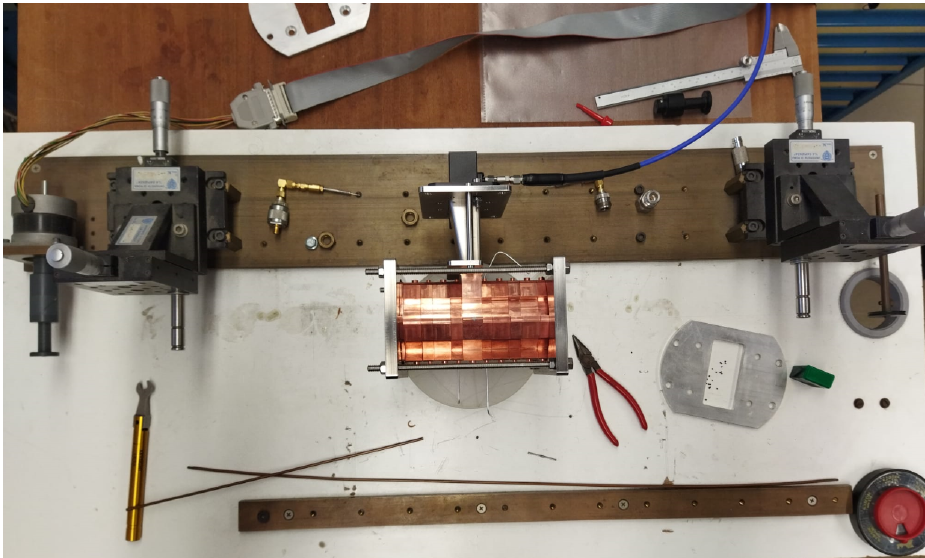
Figure 7. C-band linac prototype at Sapienza Accelerators Laboratory, on the work